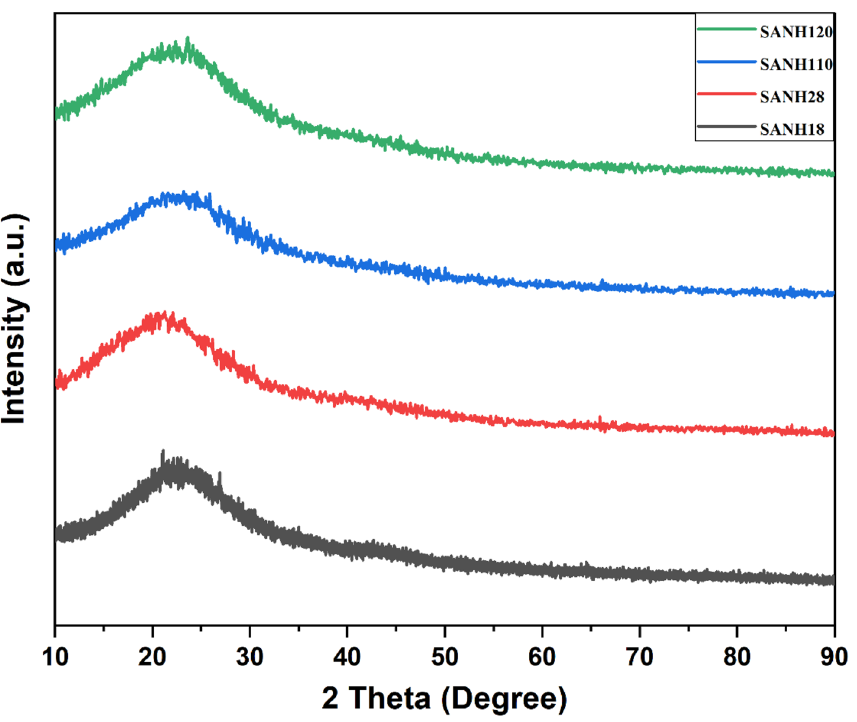
Figure 3. XRD pattern of SANH18